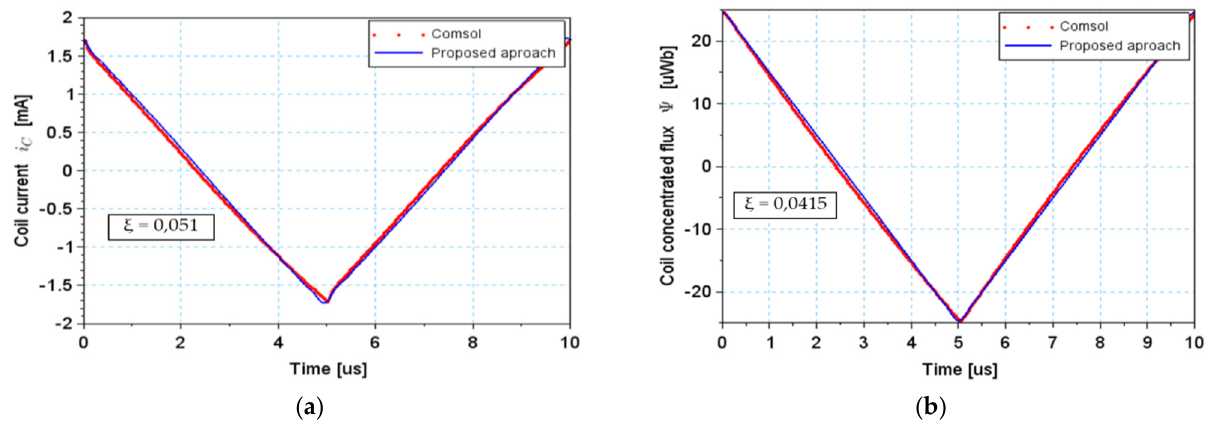
Figure 22. ( a ) Inductor current i c waveforms for the case of a rectangular voltage source and a frequency of 100 kHz. ( b ) Flux linkage Ψ waveform for the case of a rectangular voltage source and a frequency of 1